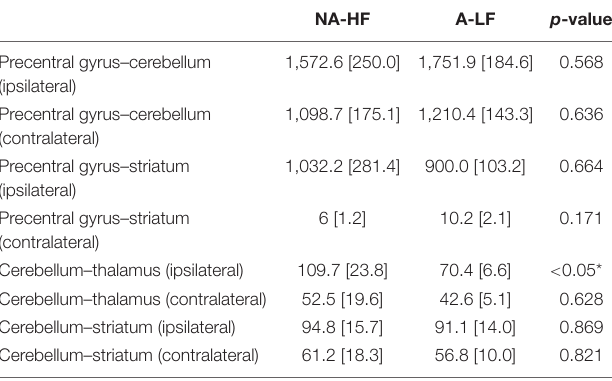
TABLE 3 | The number of fiber connectivity between motor related brain regions. NA-HF A-LF p